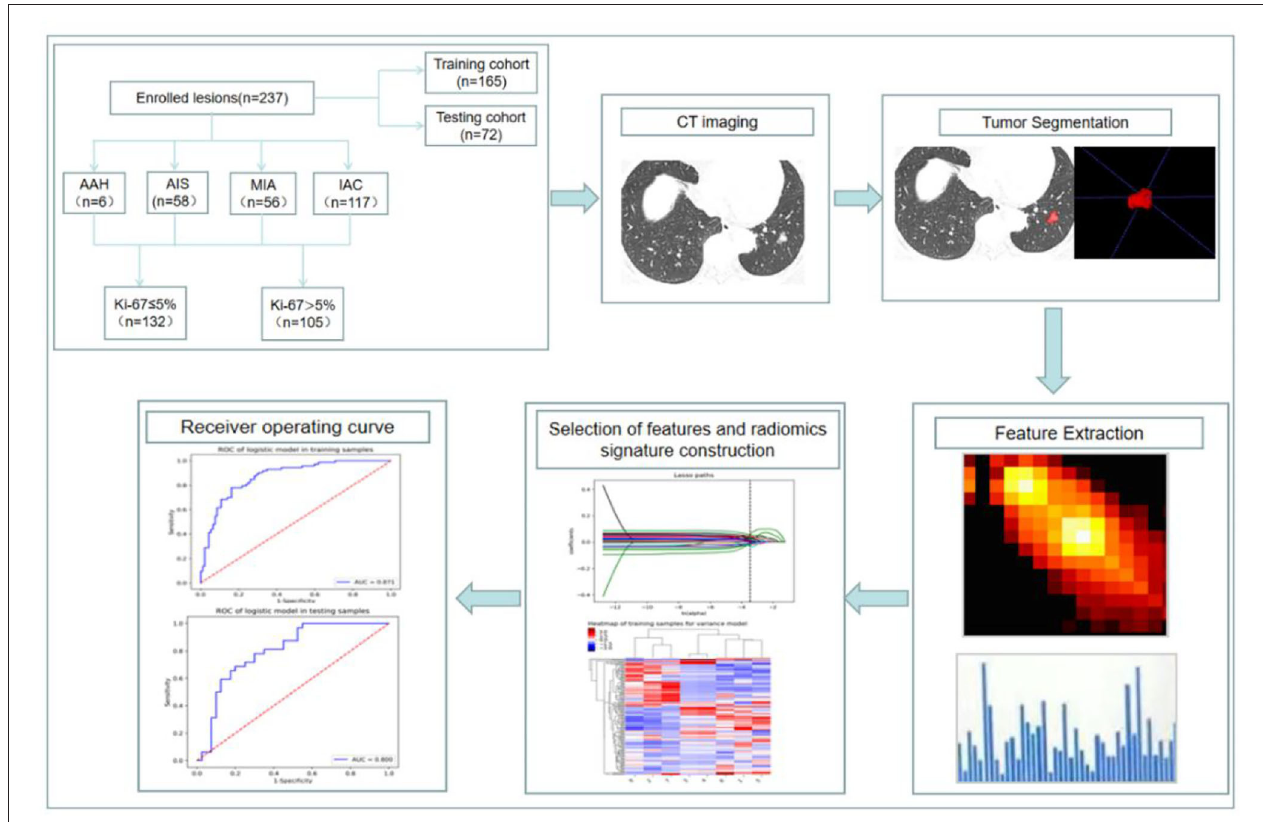
FIGURE 1 | Flowchart of constructing a CT radiomic feature model to predict the Ki-67 expression level in lung adenocarcinoma.